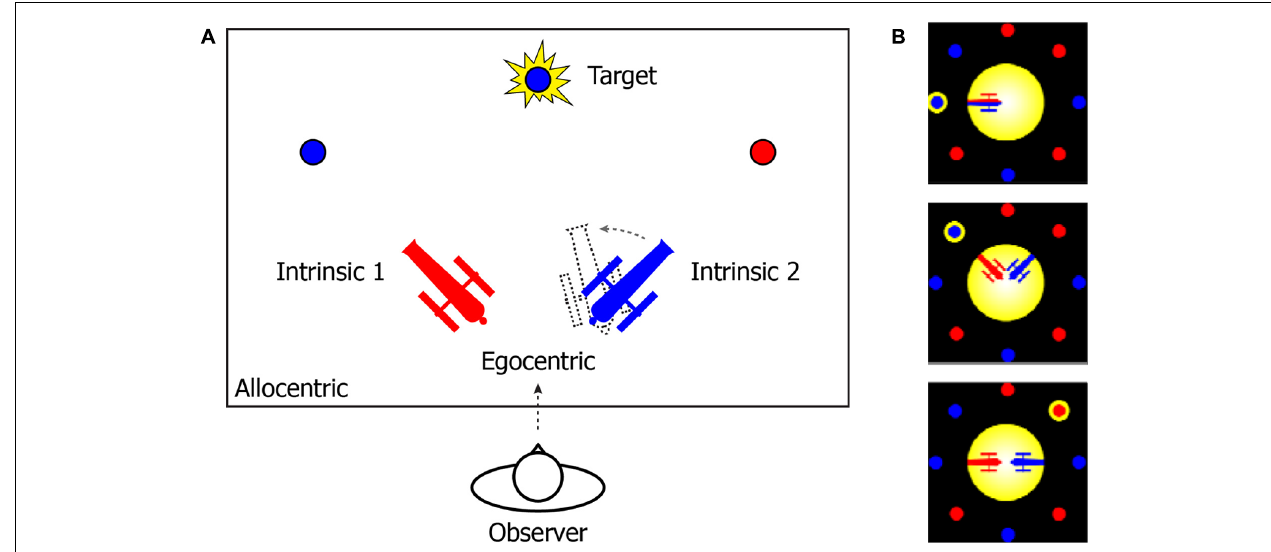
computer screen. After a one-second pause, a randomly selected pellet would flash as the target.The participants’ task was to use the arrow keys to rotate the cannon in the same color of the target toward the target as quickly as possible.The cannons’ orientations and the ratio between the number of red and blue pellets were varied across trials.The angles between two cannons were either “conflict-absent” (zero degree) or “conflict-present” (90 or 180 ◦